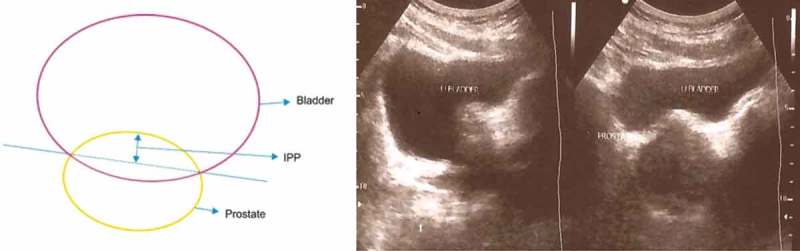
The vertical distance from the tip of the protrusion to the base of bladder was measured; longitudinal and sagittal views of the bladder and prostate using TAUS.